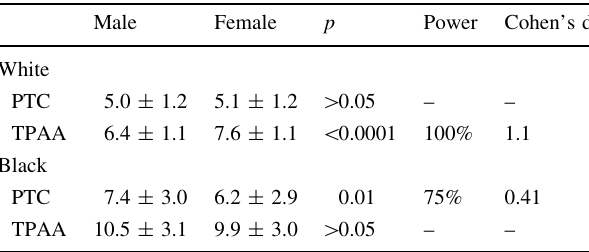
Table 4 Sub-group analysis showing the influence of gender on the amount of posterior tibial slope with posterior tibial cortex (PTC) and tibial proximal anatomical axis (TPAA) methods in patients of the same ethnicity